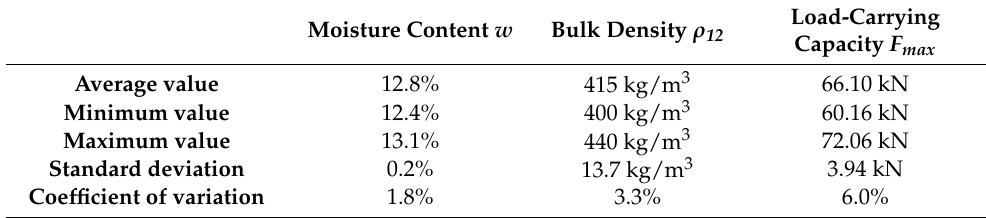
Table 5. Results of the experimental testing of H1 specimens.